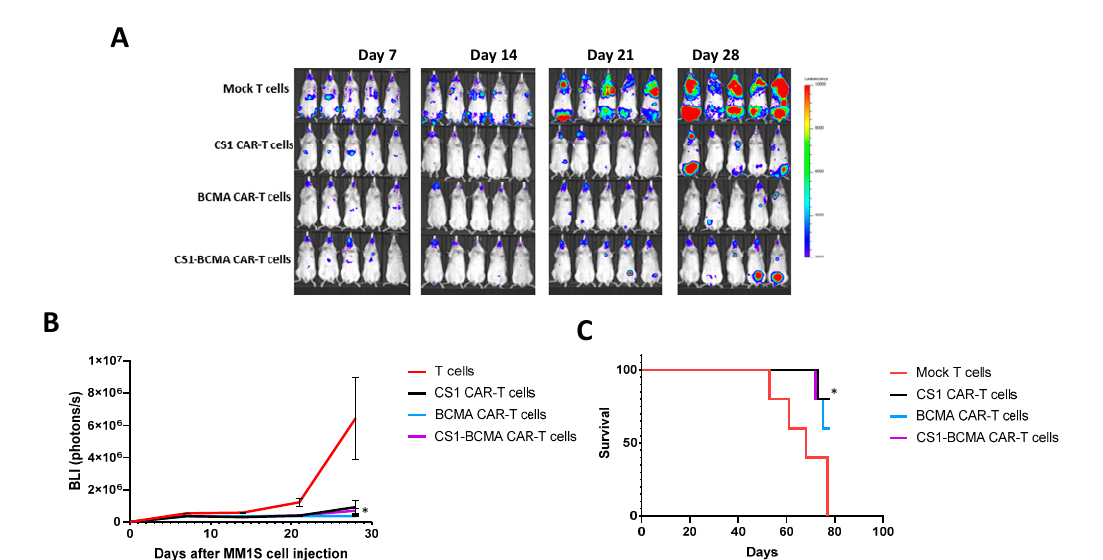
Figure 5. CS1-BCMA CAR-T cells block MM1S multiple myeloma xenograft tumor growth. ( A ) Bioluminescent imaging of mice injected with CS1-CAR-T cells, BCMA-CAR-T cells, CS1-BCMA-CAR-T cells, and mock T cells are shown. ( B ) Quantification of BLI signal. * p < 0.05, CS1-BCMA, CS1, and BCMA-CAR-T cells versus T cells, Student’s t -test. ( C ) CS1-CAR-T cells and CS1-BCMA CAR-T cells signficiantly prolong mouse survival. Kaplan–Meier curve showing survival of CS1-BCMA CAR-T cells versus control T cells. * p < 0.05, ANOVA